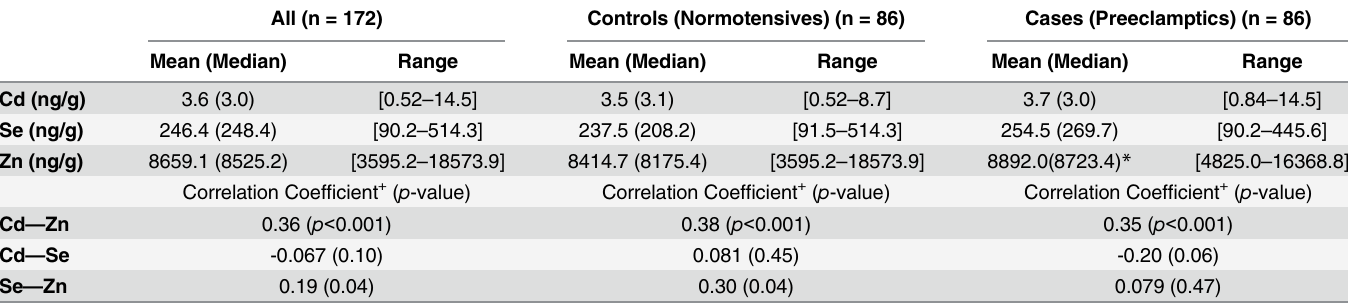
Table 2. Levels and correlations of placental metals in all subjects, normotensives (controls), and preeclamptics (cases); all values are reported as ng/g wet weight.